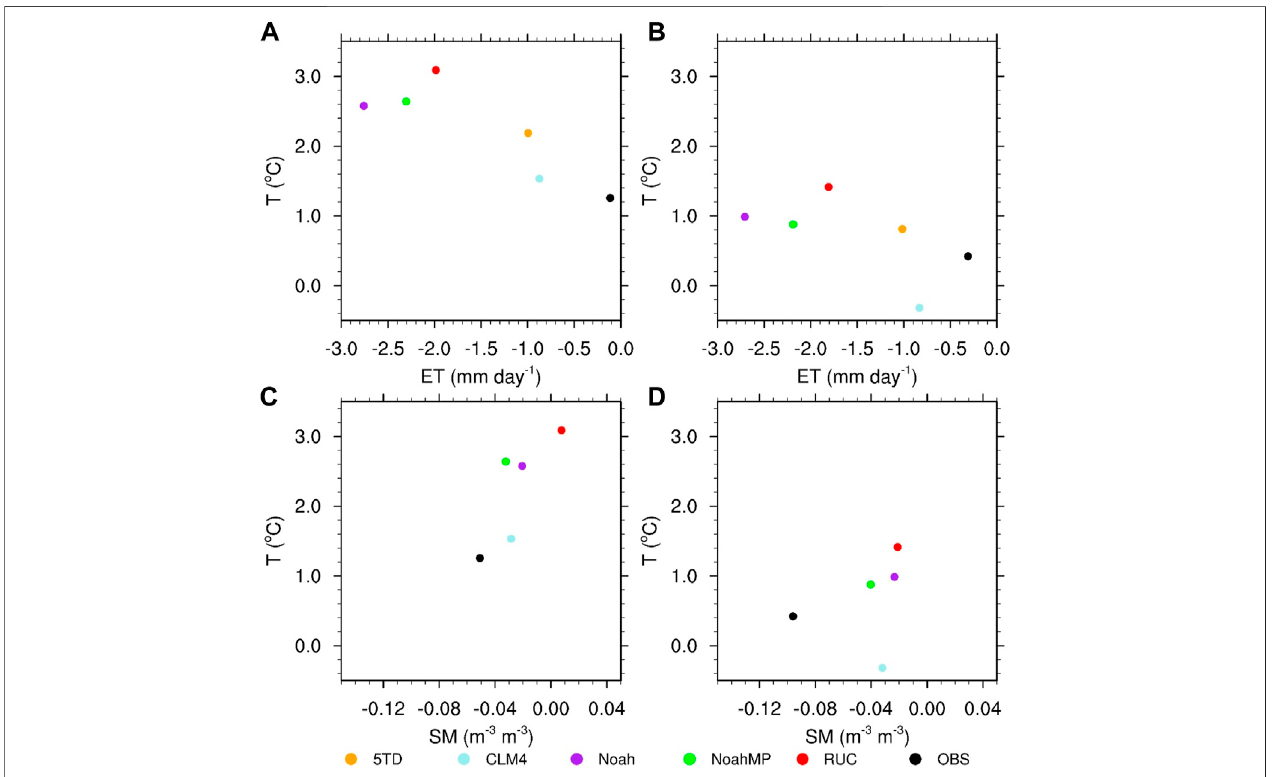
FIGURE 8 | The relationship between daily maximum temperature and ET for (A) 2013 and (B) 2017. (C,D) Same as (A,B) , but for surface soil moisture over Shanghai (30.8 ° – 31.5 ° N 120.7 ° – 122 ° E).